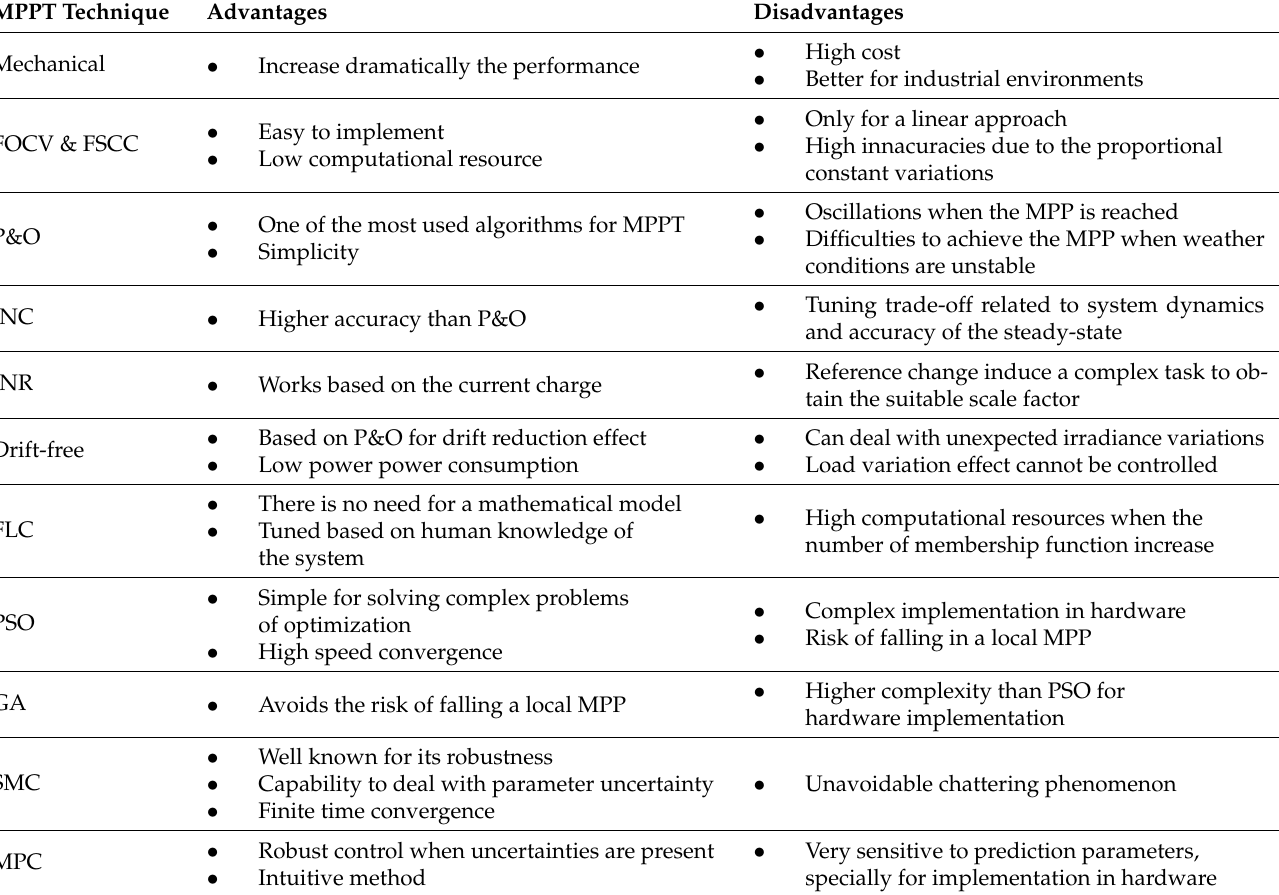
Table 1. Summary of advantages and disadvantages of the analyzed MPPT algorithms. MPPT